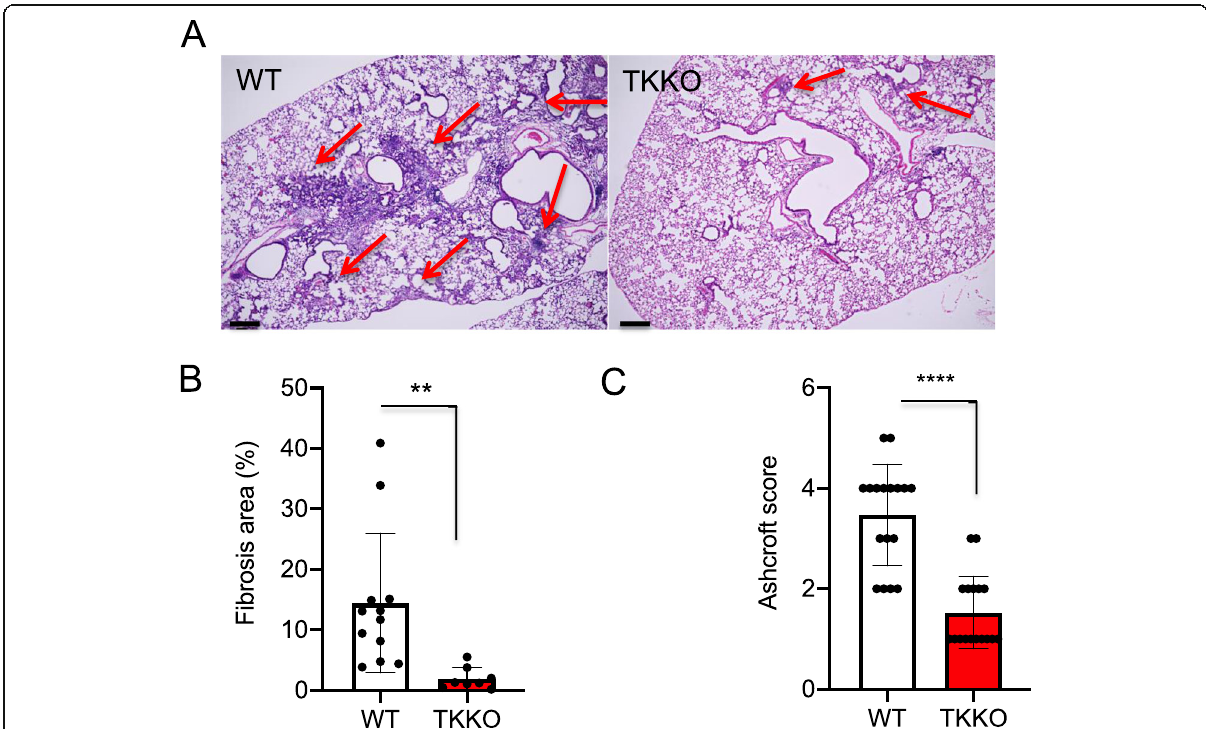
Fig. 2 BLM-induced pulmonary fibrosis formation was suppressed in TKKO mice. a Hematoxylin-eosin staining of the lung in WT mice and TKKO mice on day 21 after BLM treatment. The red arrow indicates the fibrotic area. Bar = 200 μ m. b The fibrotic area in the lung on day 21. Data are expressed as the mean ± SD (n = 8-12 mice per group). * *p < 0.01 versus WT mice. c Ashcroft score WT mice and TKKO mice on day 21. Data are expressed as the mean ± SD (n = 14-17 mice per group). *** *p < 0.0001 versus WT mice